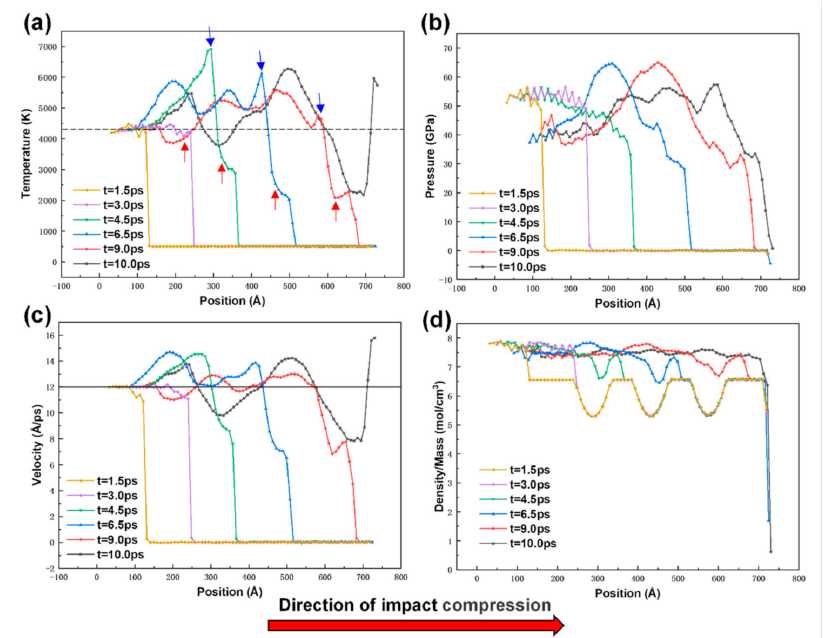
Figure 8. Variation curve of average value of atoms in all physical quantities during impact compres- sion of porous samples: ( a ) temperature; ( b ) pressure; ( c ) velocity; ( d ) ratio of density to mass (the dotted line shows the average temperature and the solid line shows the average speed of the impact compression process of the non-porous